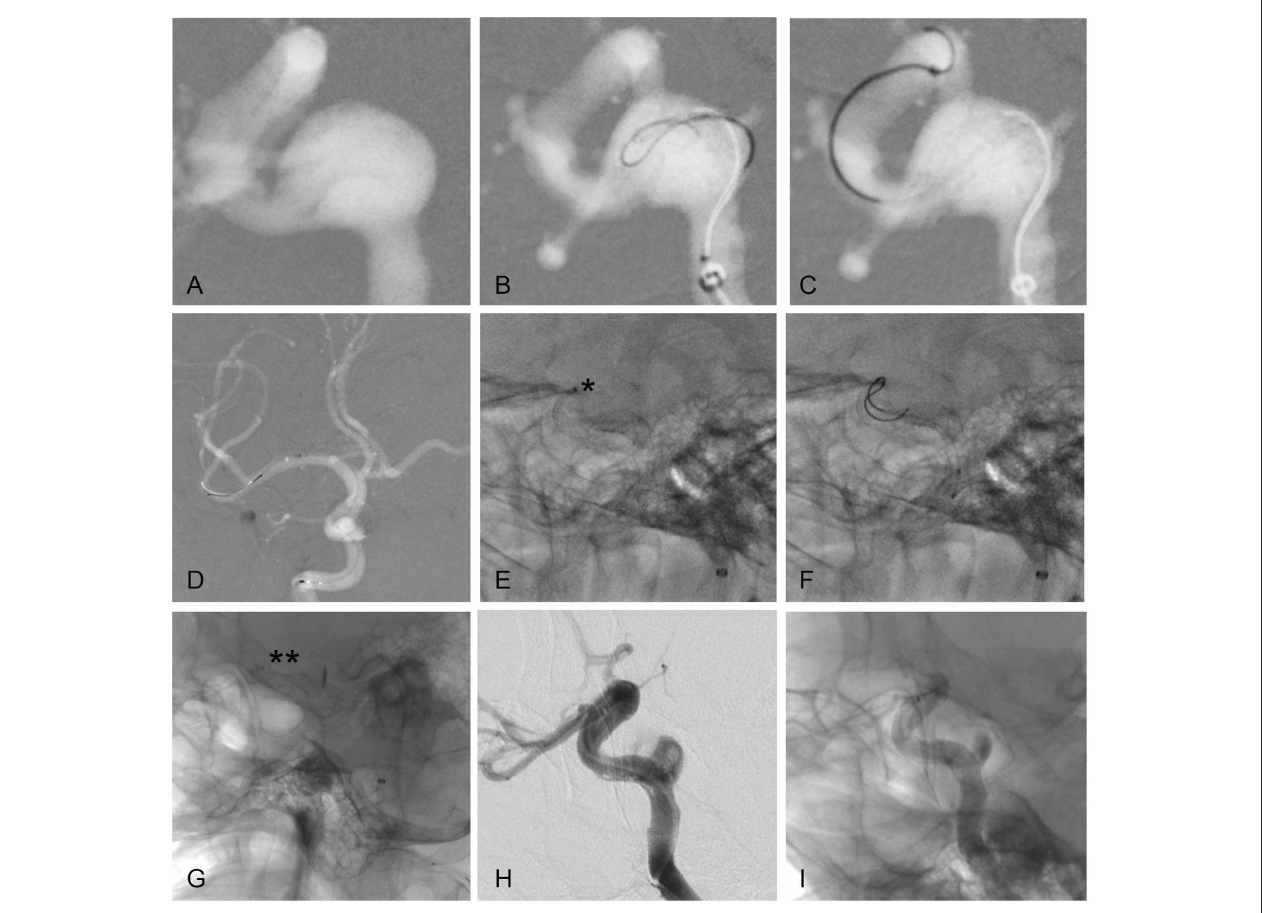
FIGURE 2 | Key steps of the PED rescue maneuver. (A) Prolapse of the proximal portion of the stent into the aneurysm sac under roadmap guidance. (B–D) A microwire loop is formed in the tip (B) , which is then passed through the WCS and distal ICA (C) and into the middle cerebral artery (D) . (E) Insufficient opening of the distal PED (asterisk). (F,G) Repeated massage with the microwire facilitated distal PED opening (double asterisks). (H,I) Angiography immediately after the procedure revealed that the contrast agent was trapped in the aneurysm cavity, and the typical “meniscus sign” could be